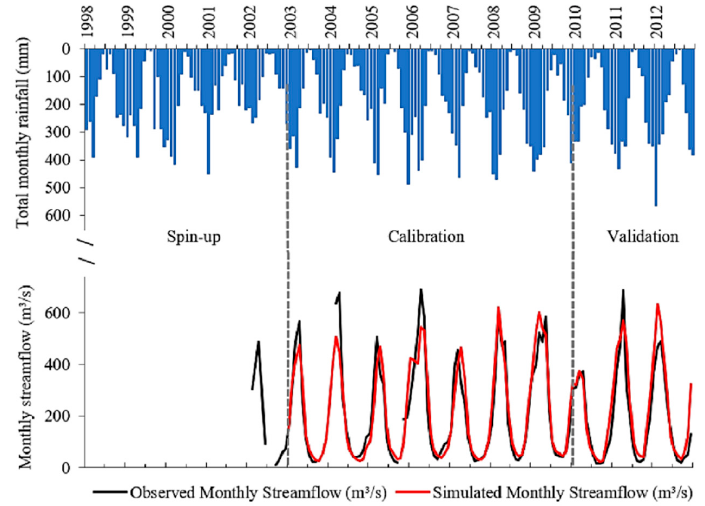
Figure 3. Observed and simulated streamflow at the basin’s outlet, and rainfall data used for the model spin-up, calibration, and validation.